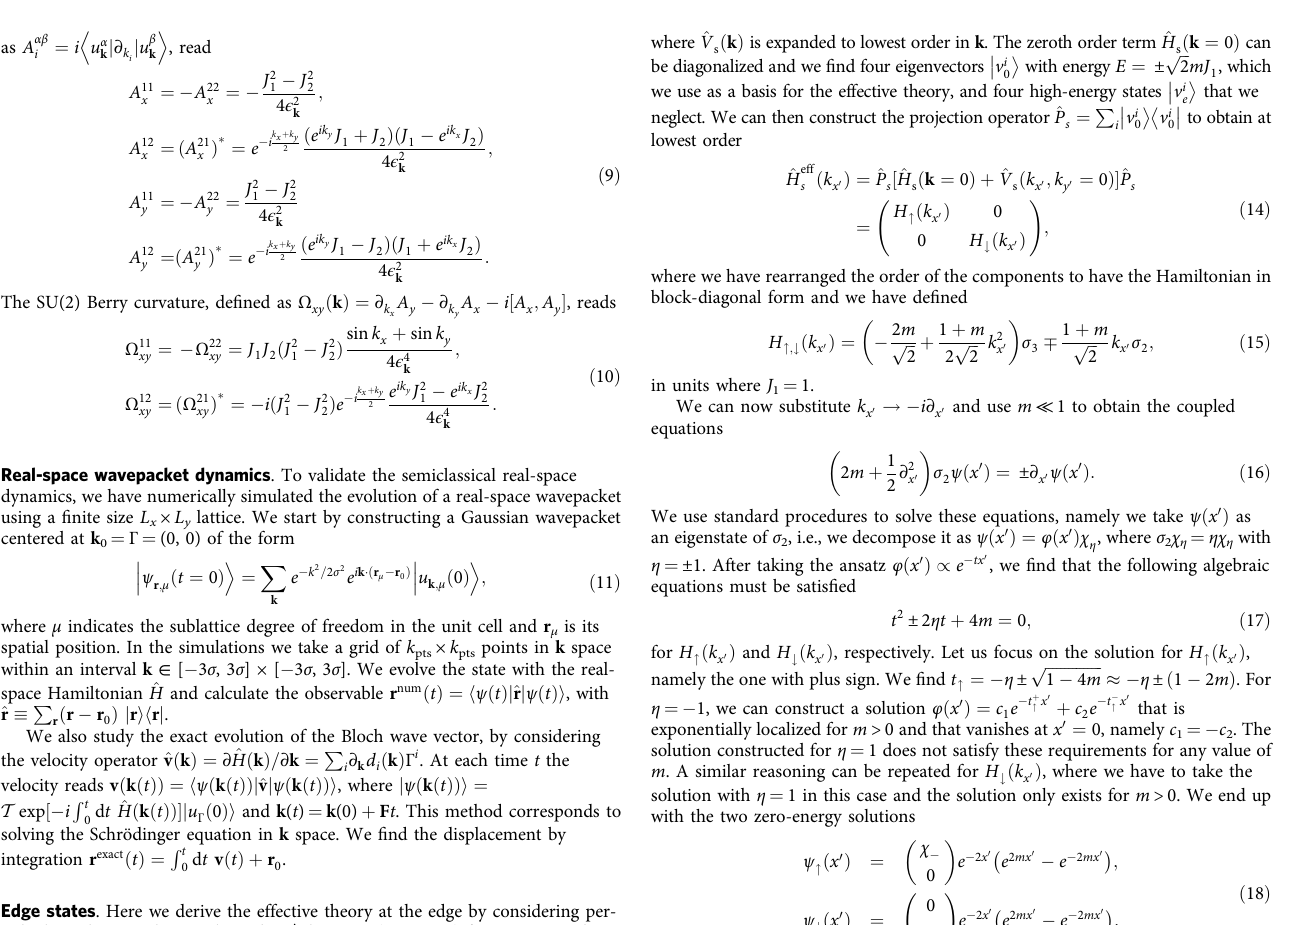
Fig. 5 Edge states. a Stripe geometry with periodic boundary conditions along ^ y 0 . b Unit cell choice used to develop the